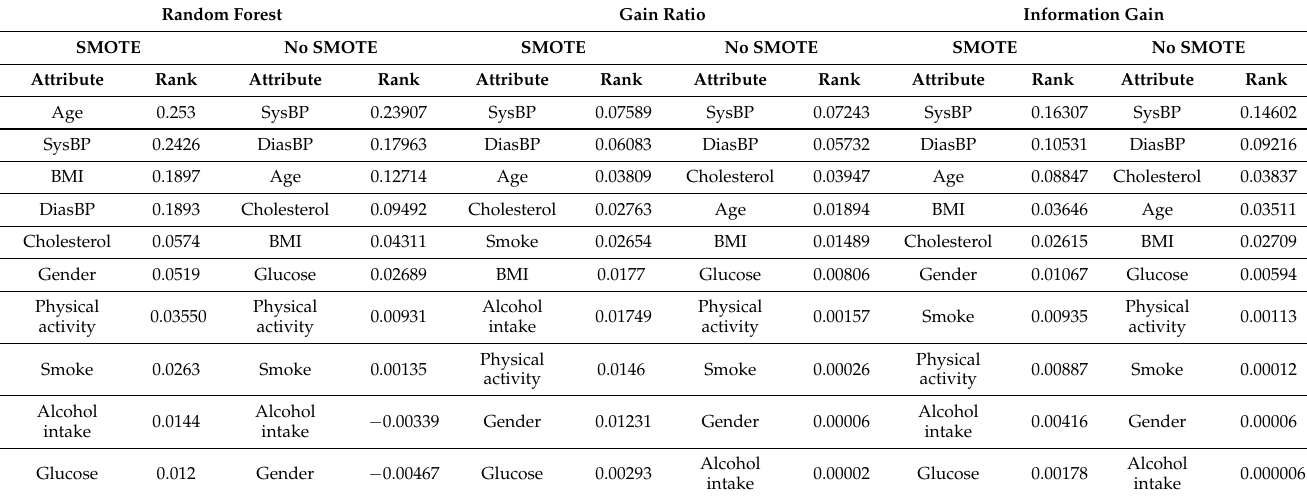
Table 2. Features ranking before and after class